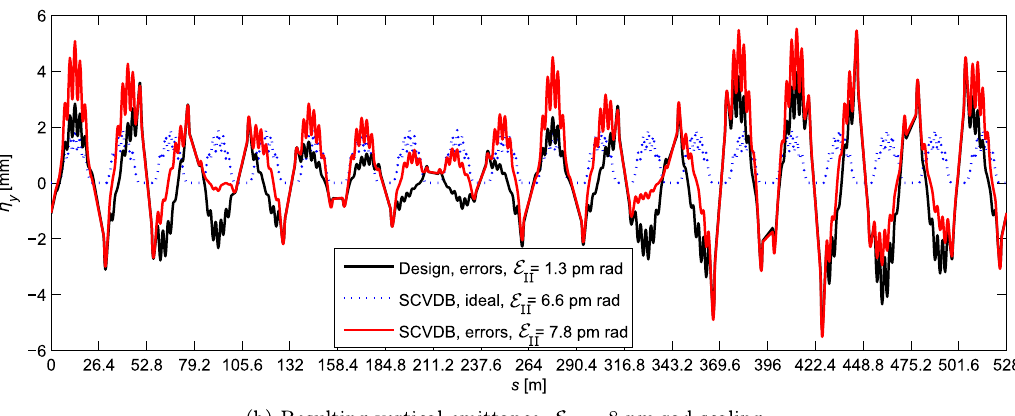
FIG. 6. Vertical dispersion in the entire storage ring (20 achromats) for the design lattice and Case 3 lattice with identical error seed for two scalings. The ideal lattice SCVDB is shown for comparison.